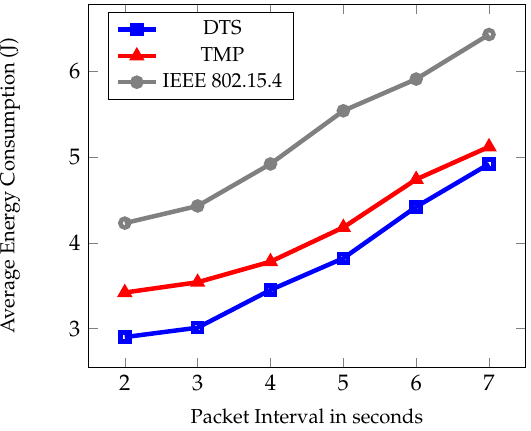
Figure 12. Average energy consumption under different packet